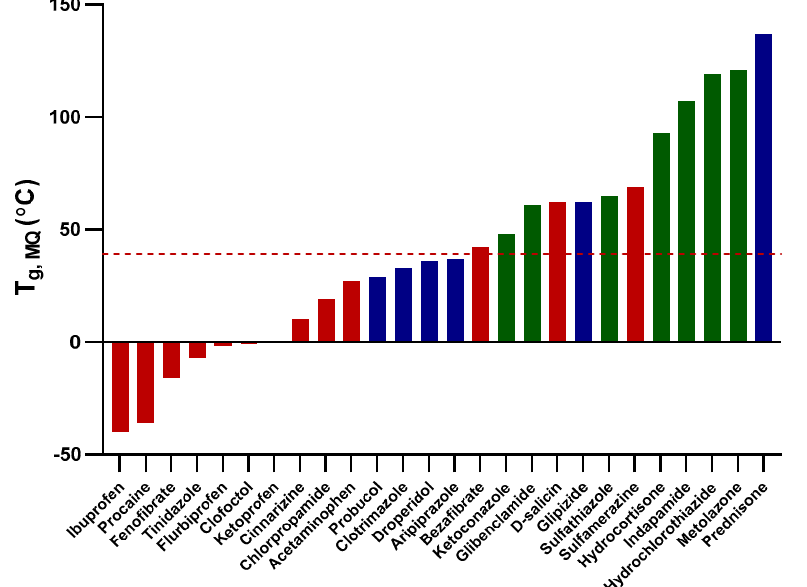
Figure 3. A bar chart indicating the glass transition temperatures (T g, MQ ) of the melt-quenched studied compounds in relation to the average spray-drying outlet temperature (red dashed-line; 39 °C). The solid-state forms of the compounds on spray-drying are represented by different colors: red represents fully crystalline, blue represents a mixture of amorphous and crystalline, and green represents fully amorphous compounds.